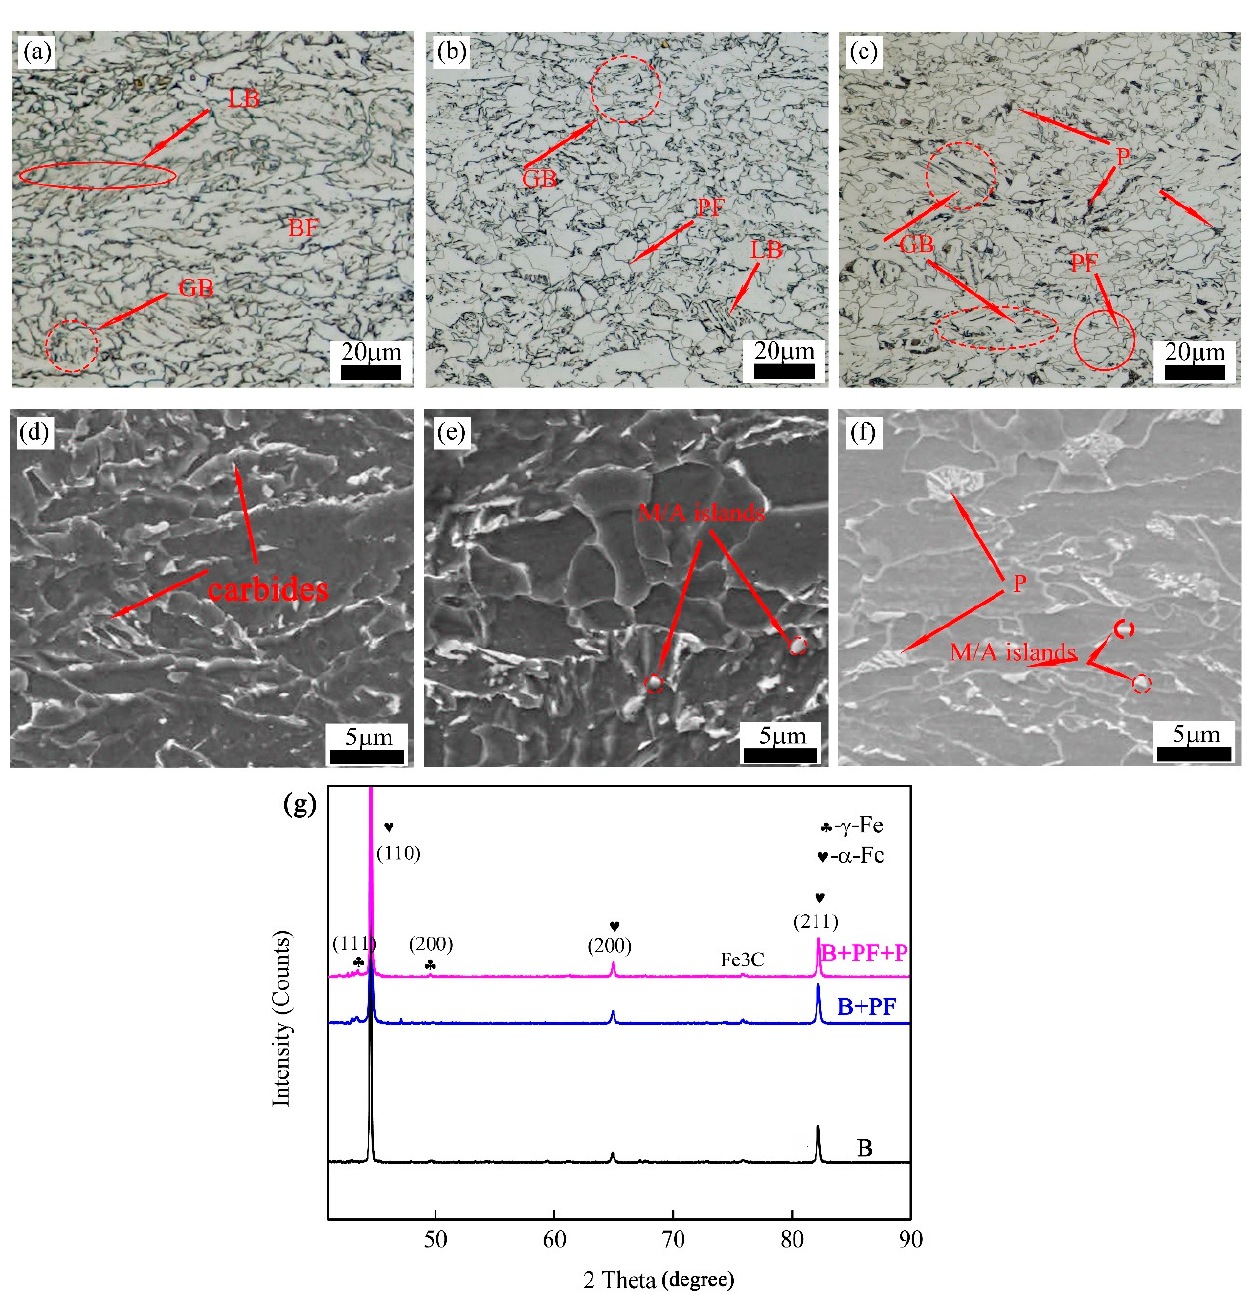
Figure 2. ( a , d ) Single-phase (B); ( b , e ) dual-phase (B + PF); ( c , f ) triple-phase (B + PF + P); and ( g ) XRD analysis